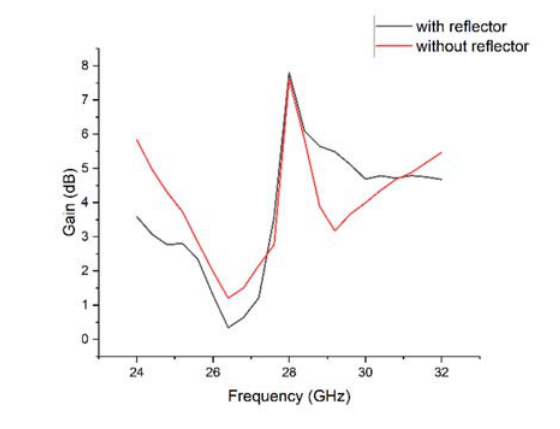
Fig 11 . Comparison of gain antenna with and without reflector